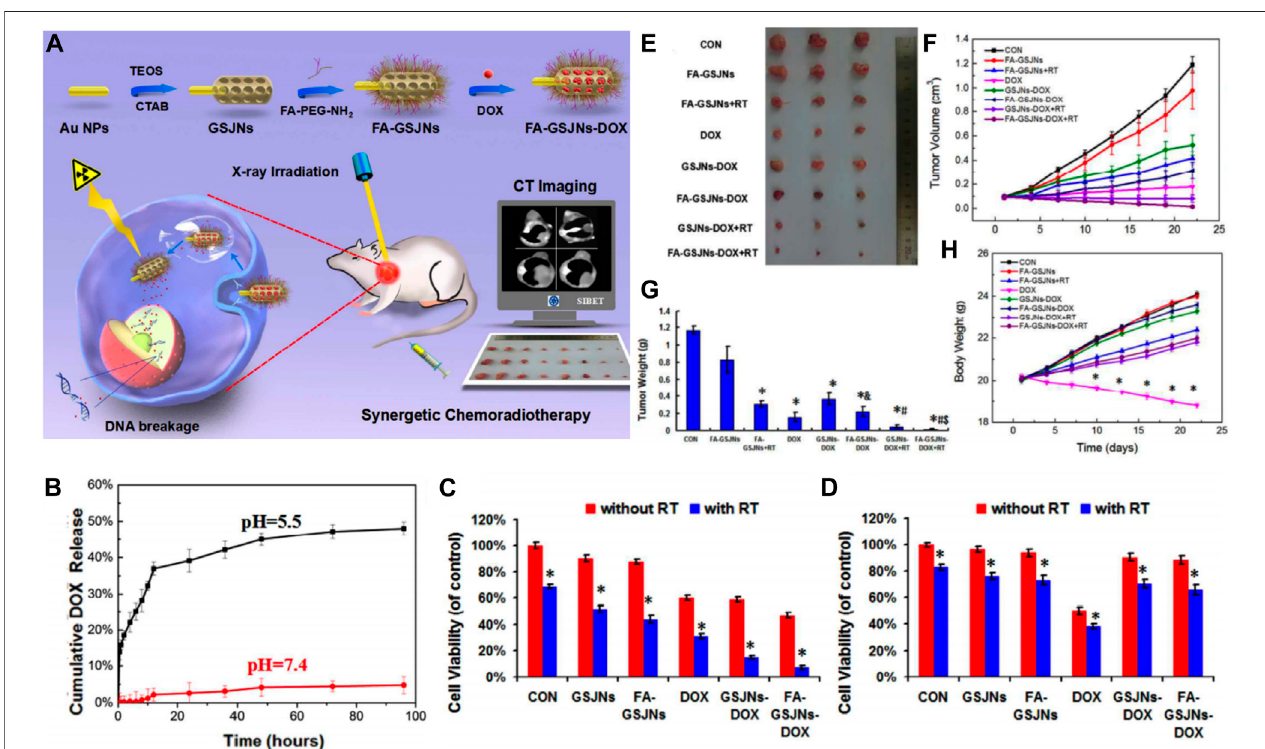
FIGURE 8 | (A) Schematic illustrations of the synthetic procedure for the DOX-loaded Au-mesoporous silica Janus NPs and application for synergetic chemoradiotherapy and CT imaging in HCC theranostics. (B) pH-dependent drug-release pro fi les of FA-GSJNs-DOX. Cytotoxic pro fi le of FA-GSJNs-DOX against (C) SMMC-7721 cells and (D) HL-7702 cells for 24 h. In vivo chemoradiotherapy effect: (E) Tumor photographs, (F) volume, (G) weight, (H) body weight from mice in each group over 23 days. Reprinted with permission from Wang et al. (2017d). Copyright (2017) American Chemical